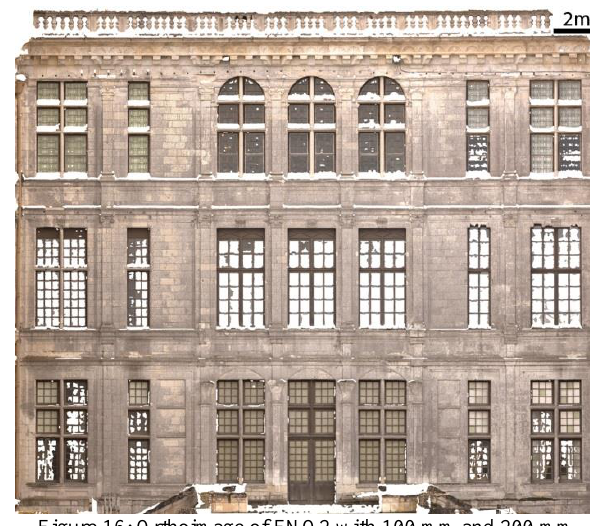
Figure 16: Orthoimage of FNO2 with 100 mm and 200 mm focal length